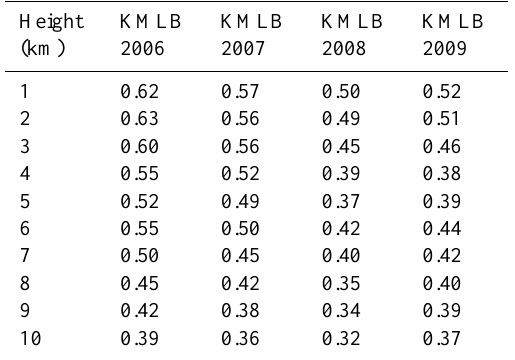
Table 3. The effect of using radar measurements from different heights on the performance of the NN rain rate estimator. Data from year 2006 to 2009 over KMLB. (Hourly rainfall